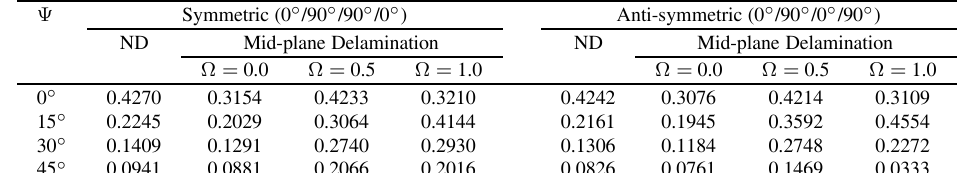
Table 8 Comparative statement for NDFF of four layered a) Symmetric and b) Anti-symmetric graphite-epoxy cross-ply